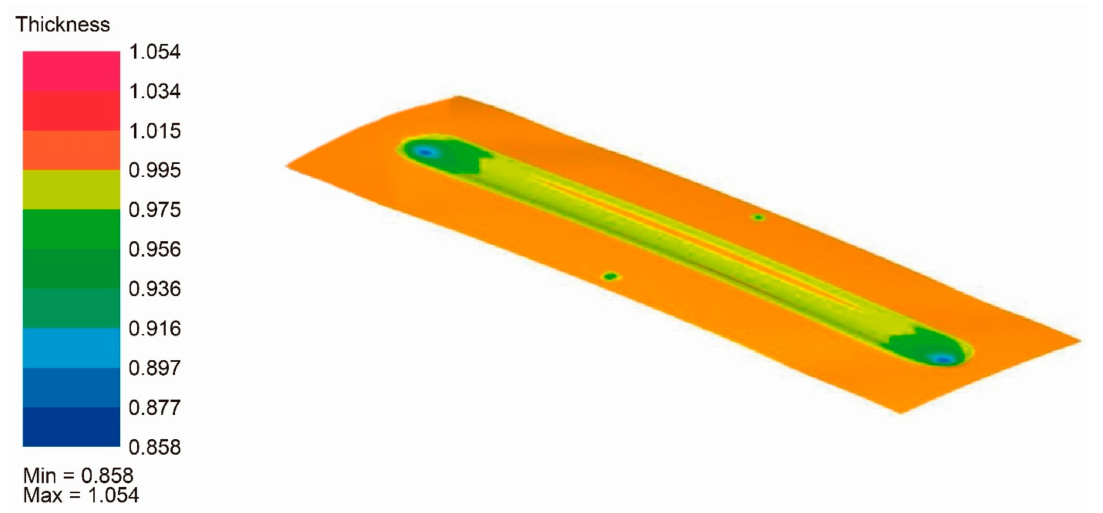
Figure 6. Simulation of the minimum thickness t min (mm) in the stamping area.